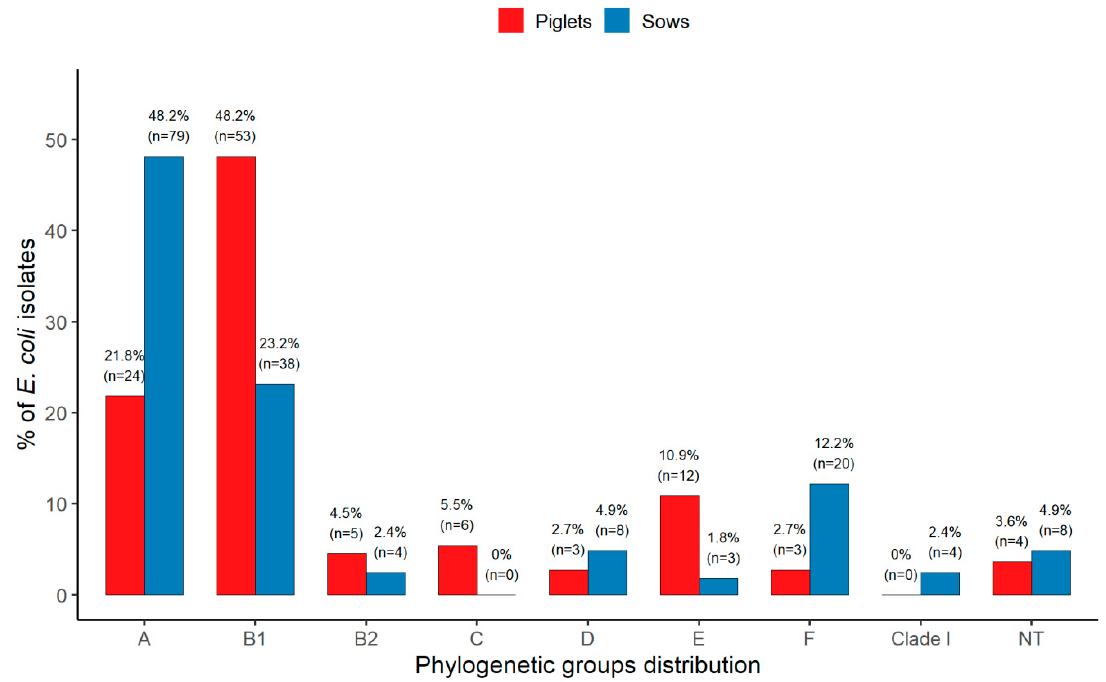
Figure 1. Extended phylogenetic structure of the Escherichia coli ( E. coli ) isolates derived from piglets and sows. Note: NT— not typeable.